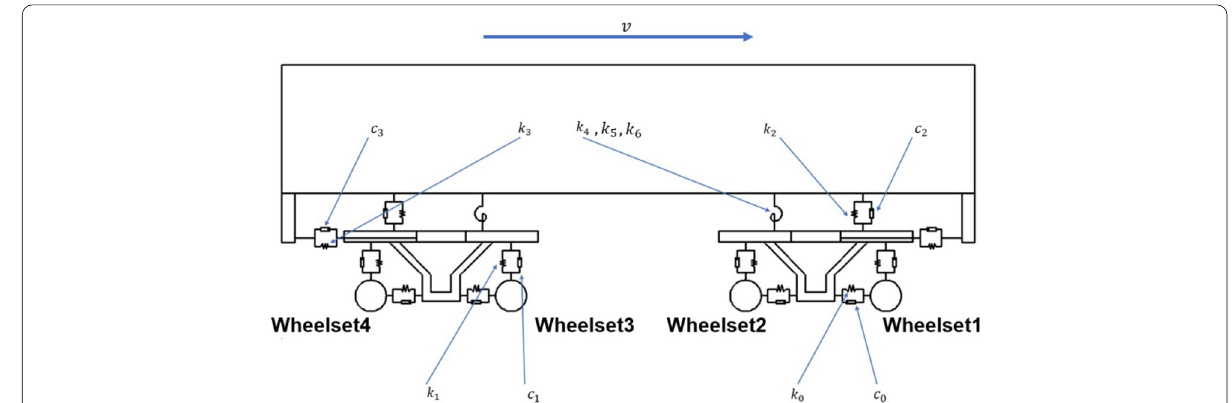
Figure 6 Vehicle dynamic model